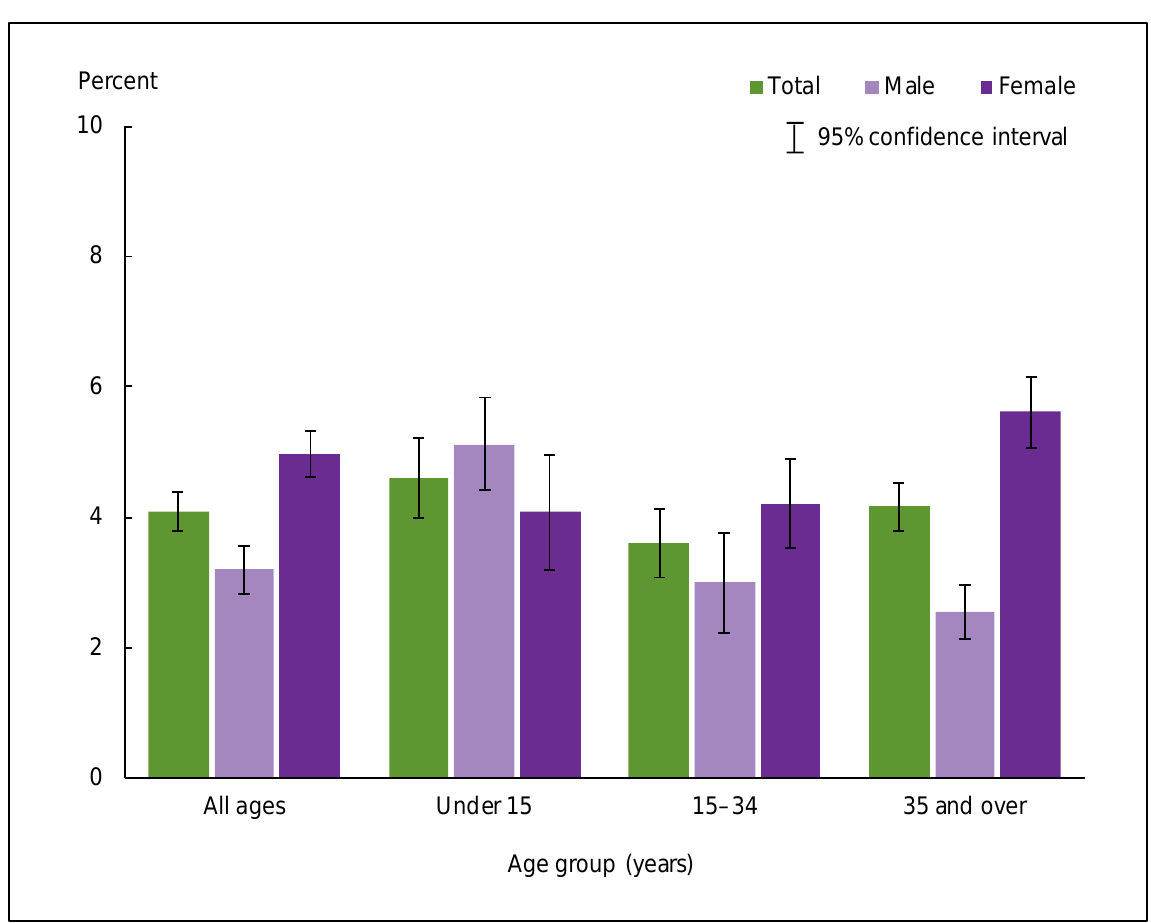
Figure 15.2. Percentage of persons of all ages who experienced an asthma episode in the past 12 months, by age group and sex: United States,